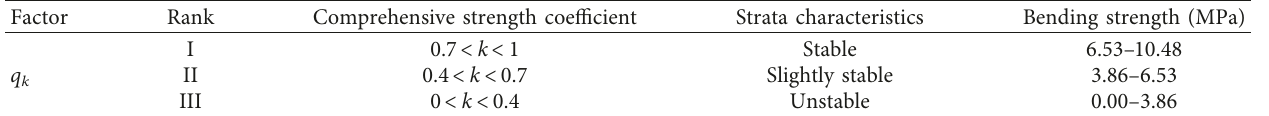
Table 7: Classification table based on the comprehensive influence coefficient of the composite roof